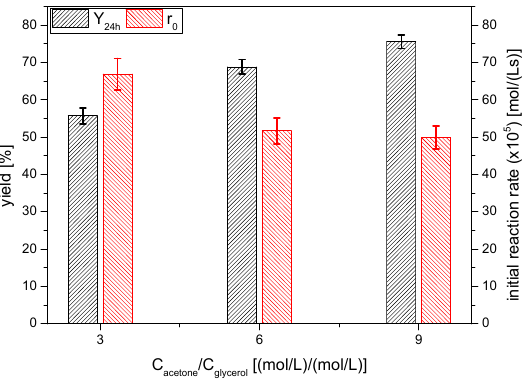
Figure 11. Influence of the molar excess of acetone on the yield of solketal 1 at 24 h and the initial reaction rate (Reaction conditions: acetone/glycerol molar ratio, 6:1; temperature, 25 °C).